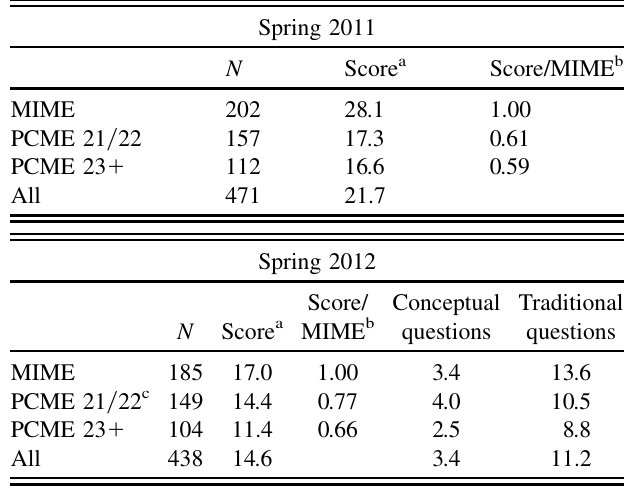
TABLE VIII. Z -score comparison of PCME 21 = 22 Mechanics final exam scores (traditional problem-solving questions